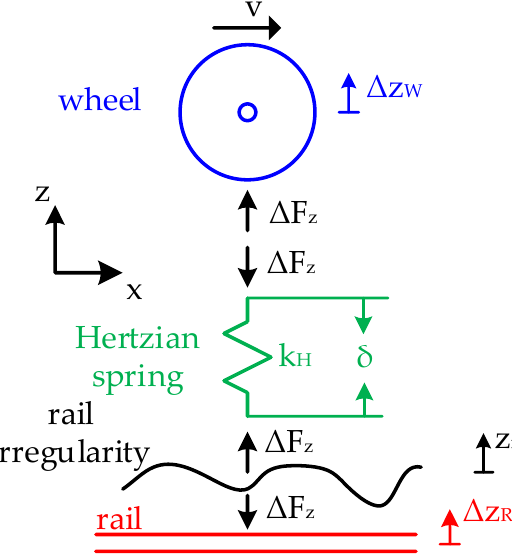
Figure 7. Scheme of the vertical wheel–rail interaction.